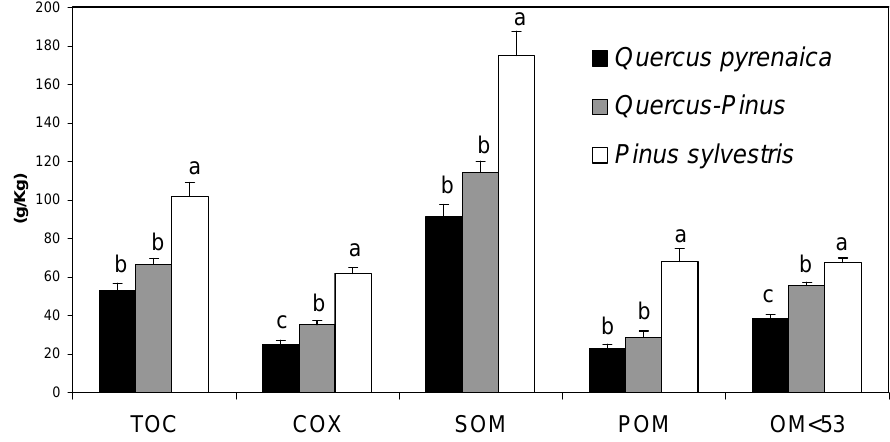
FIGURE 2. Means of total soil organic carbon (TOC), Walkey-Black C (COX), total soil organic matter (SOM), particulate organic matter (POM), organic matter fraction below 53 µm (OM < 53) in the mineral soil at 0- to 15-cm depths in the Quercus , Pinus, and Quercus-Pinus stands at Valsaín forest. Different letters denote significant differences between plots ( p < 0.05). Error bars represent ± SE (n =